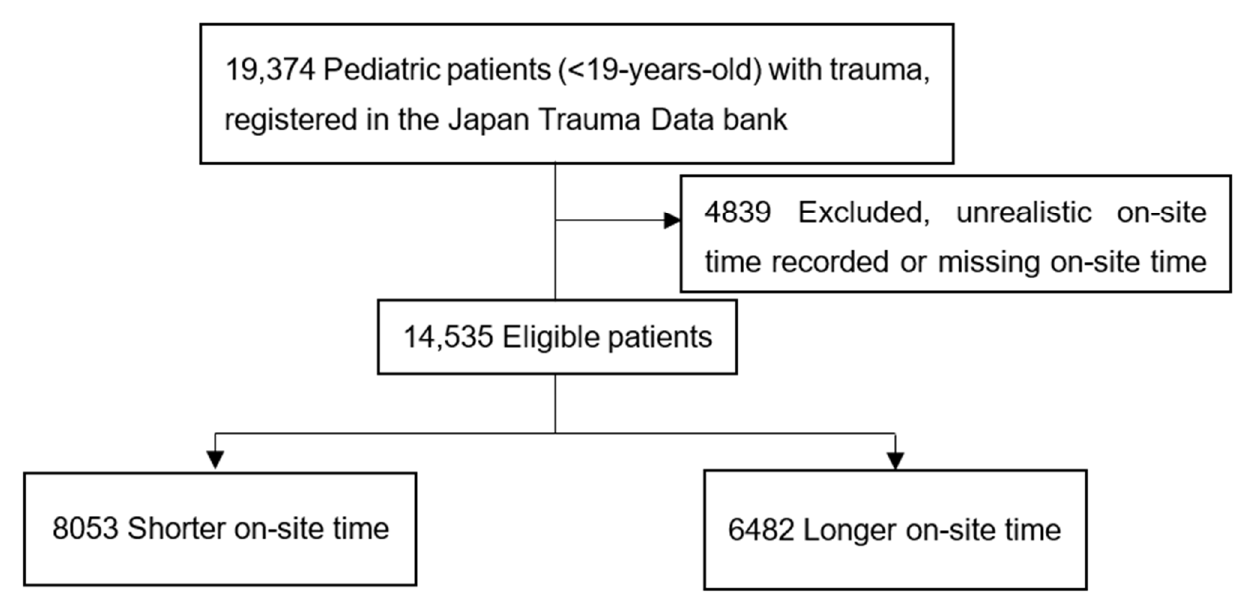
Figure 1. Patient flow chart.